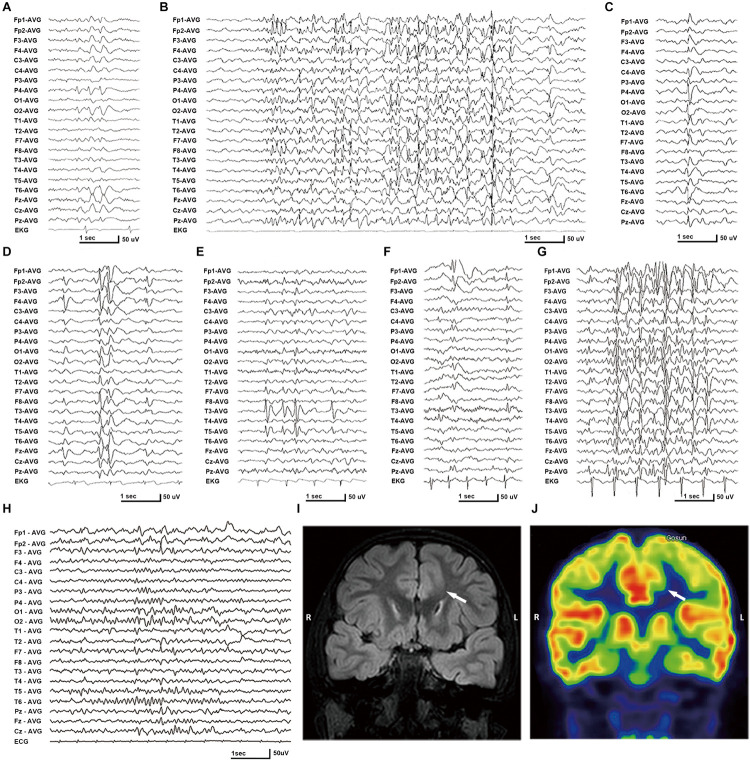
Electroencephalography (EEG) and imaging data of the patients with DEPDC5 mutations. (A) EEG of proband in family A (II-1) shows spikes and waves predominantly in the right parietal region. (B,D) Proband in family C (II-1) shows generalized polyspikes and slow waves (B) and multifocal discharges (C,D). (E) Proband in family E (II-1) shows spikes or spikes and waves in the left temporal lobe. (F,G) Proband in family H (II-1) shows both focal spikes and waves or spikes in the left frontal or temporal region (F) and generalized discharges (G). (H) The case with homozygous p.Pro1031His in family K (II-2) shows spikes or slow waves predominantly in the left frontal lobe; MRI shows focal cortical dysplasia in the anterior cingulate region of frontal lobe (I), which shows hypometabolic signal in PET (J).